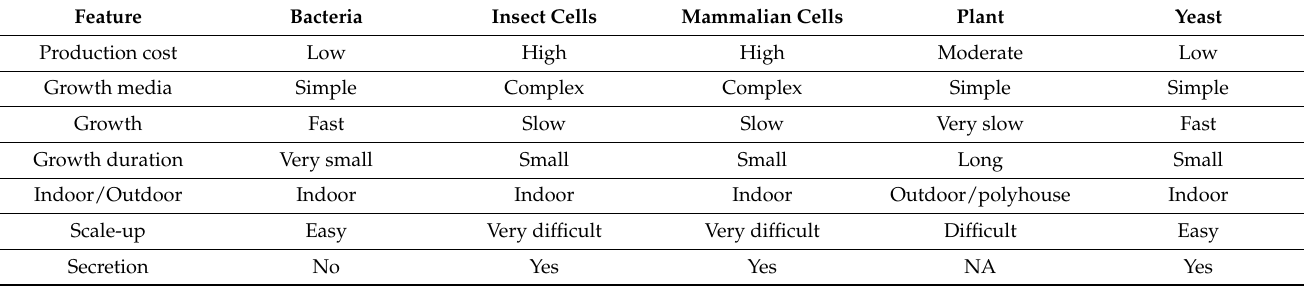
Table 1. A comparison of the different model systems used as a host for the production of VLPs [22,54].